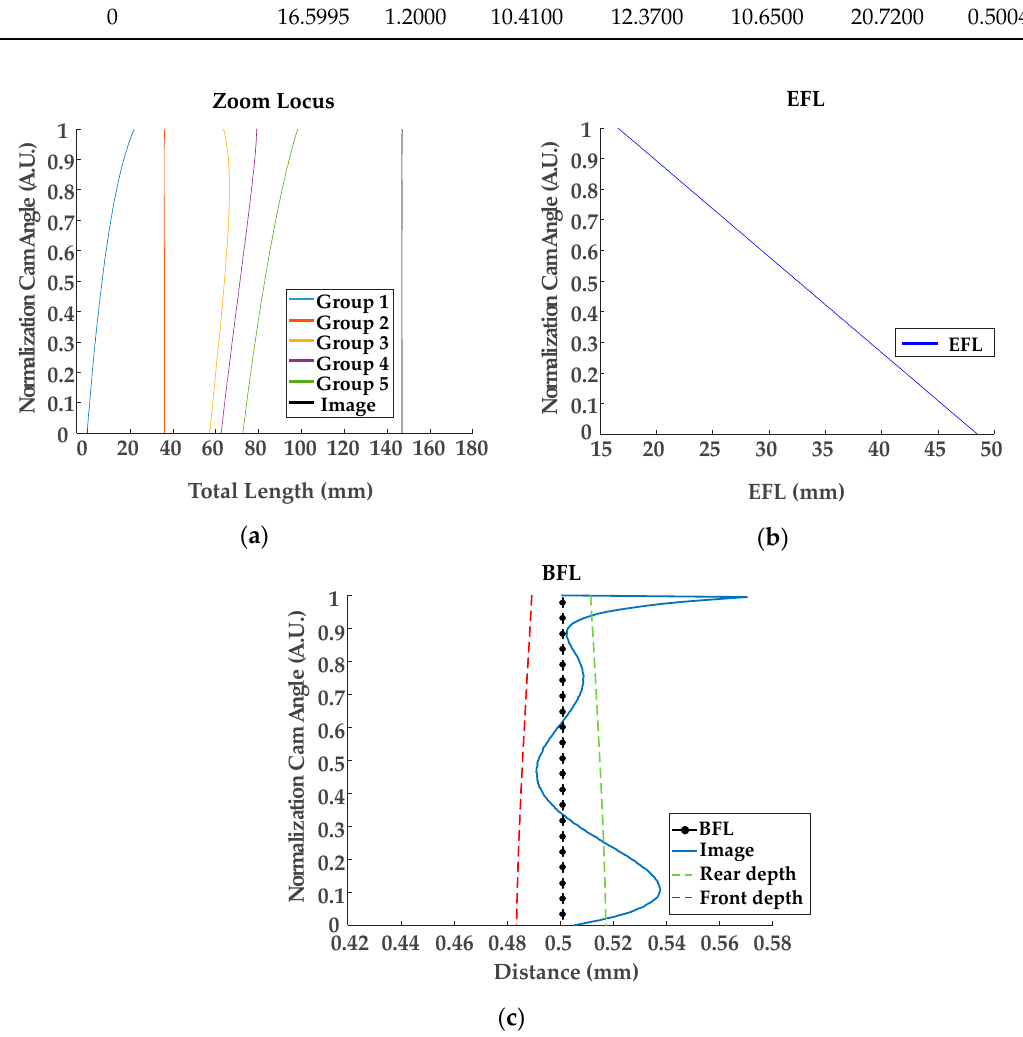
Figure 7. Linearization of EFL using the Padé approximation, as shown in Table 5. ( a ) Zoom locus of each lens group, ( b ) EFL of this optical system, and ( c ) error for image plane.